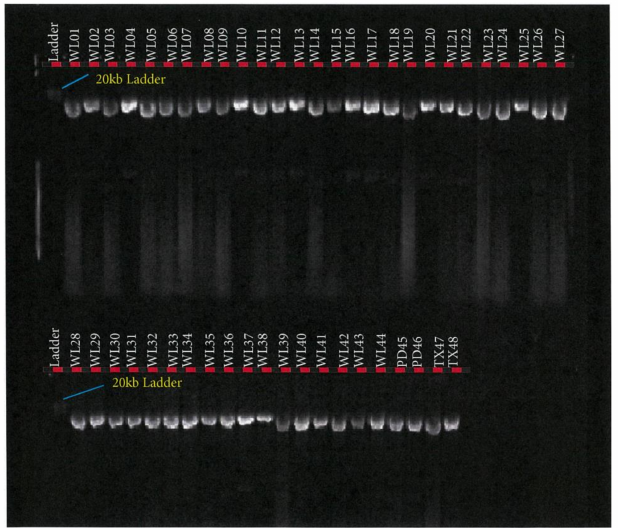
Figure 5. SCD PCR product in Tattykeel Australian White (WL), Poll Dorset (PD), and Texel (TX)